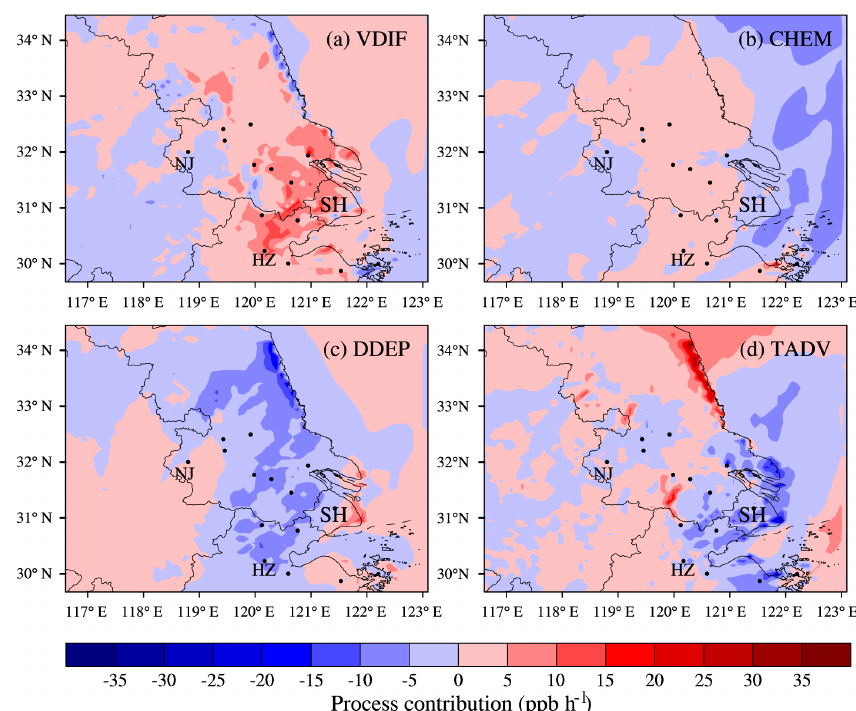
Figure 11. The difference of daytime mean contributions of main processes to O 3 formation over the YRD region between the period of 10– 12 and 7–9 August, including (a) vertical diffusion (VDIF), (b) gas chemistry (CHEM), (c) dry deposition (DDEP) and (d) total advection